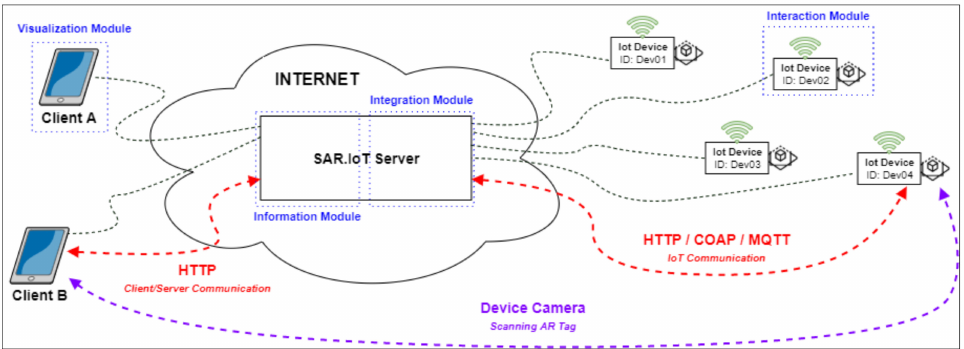
Figure 1. SAR.IoT conceptual